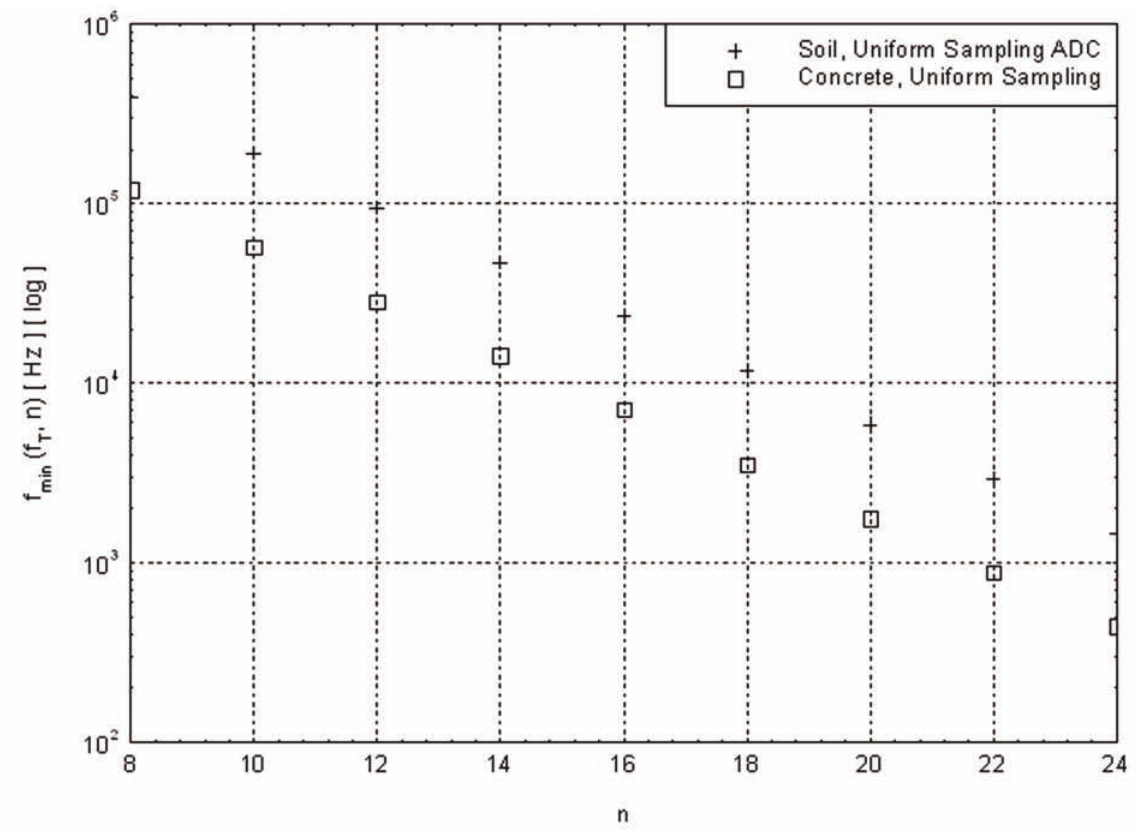
Figure 5. With reference to the operating conditions described in the caption to Figure 2 (for subsurface: nonsaturated terrestrial soil or concrete; sampling: uniform). Plot for the minimum values of frequency f limit (10%), as a function of the bit resolution n [the cut-off frequency of the transfer impedance fixed as f defined by the measurements ( f